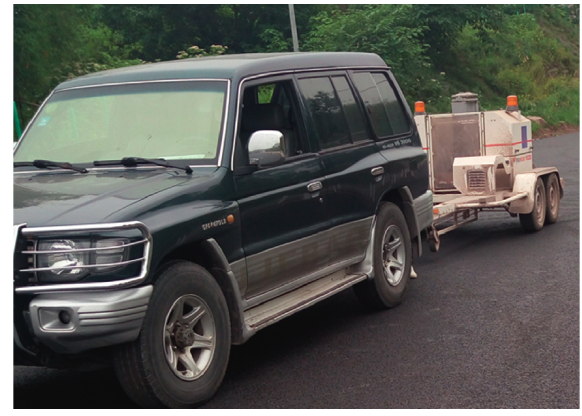
Figure 2: FWD field testing. Table 2: The distance between the sensor and the center of the loading